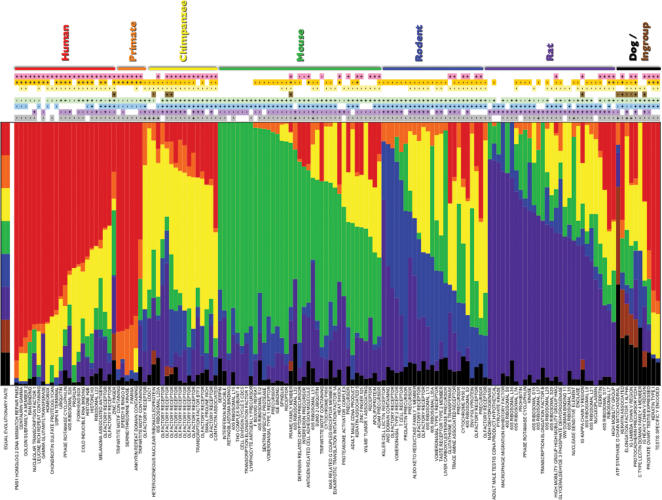
Rapidly evolving gene families in mammals.Horizontal bars indicate the relative rates of change among taxa for each family (where rate is the change in number of genes per million years).The top bar indicates the hypothetical case where each lineage has an equal evolutionary rate.Bars are partitioned by the color codes assigned to the taxon names at the far right.Boxes immediately right of each bar indicate whether changes in that family are expansions (+) or contractions (−) in each taxon.Each column of boxes represents a single taxon, color coded in the same order as the bars.Vertical bars on the right span families that were found to be least likely in the same lineage under the random model of gene gain and loss.Families with ambiguous or unknown function are left out of the figure to improve legibility.The complete statistical results are presented in Table S7.